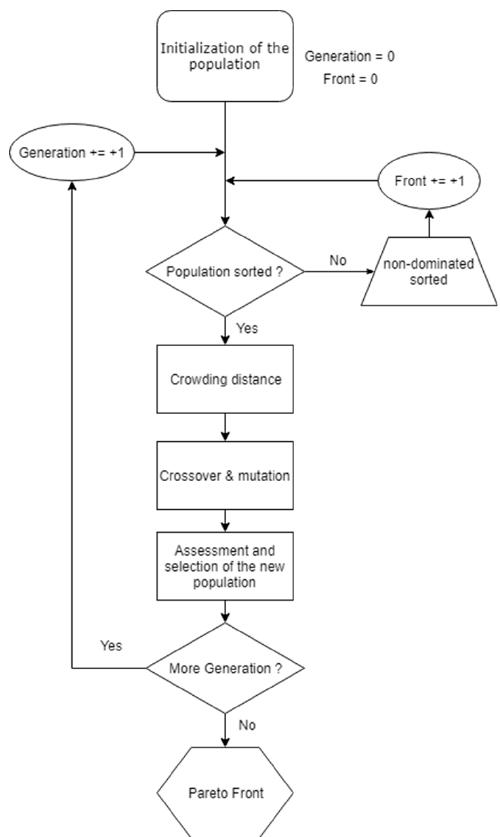
Figure 4. Flowchart of the fast, elitist, non-dominated sorting genetic algorithm (NSGA-II) .